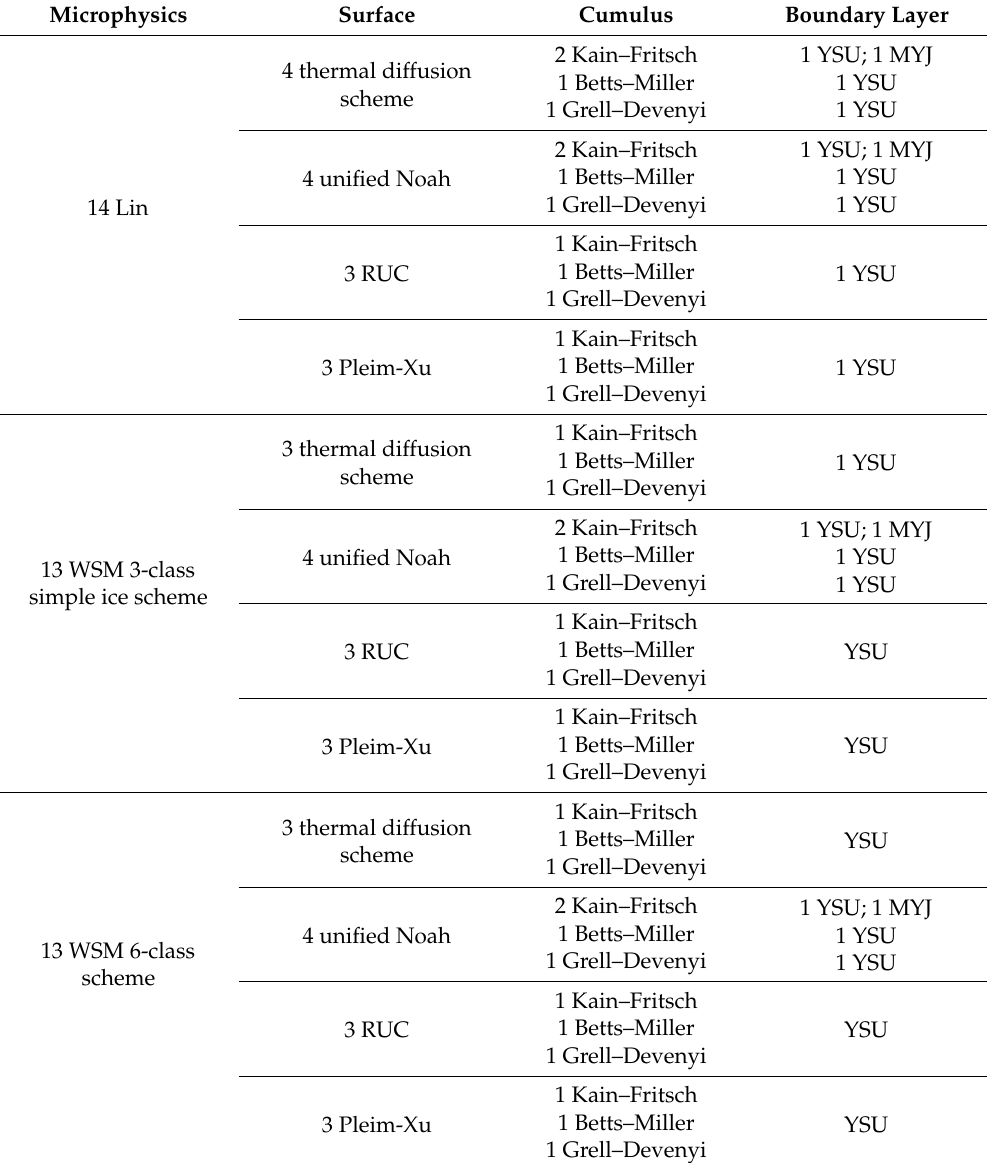
Table A1. Number of ensemble members and schemes used in multi-scheme system.